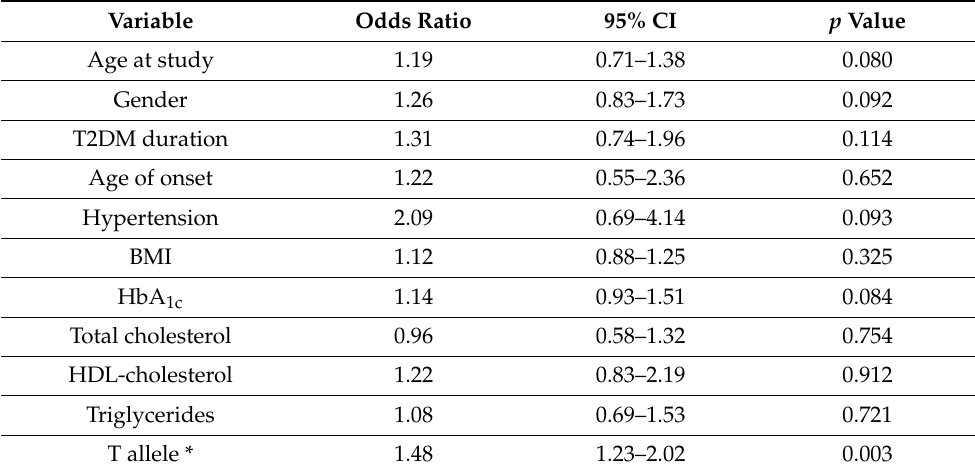
Table 4. The results of multivariate logistic regression